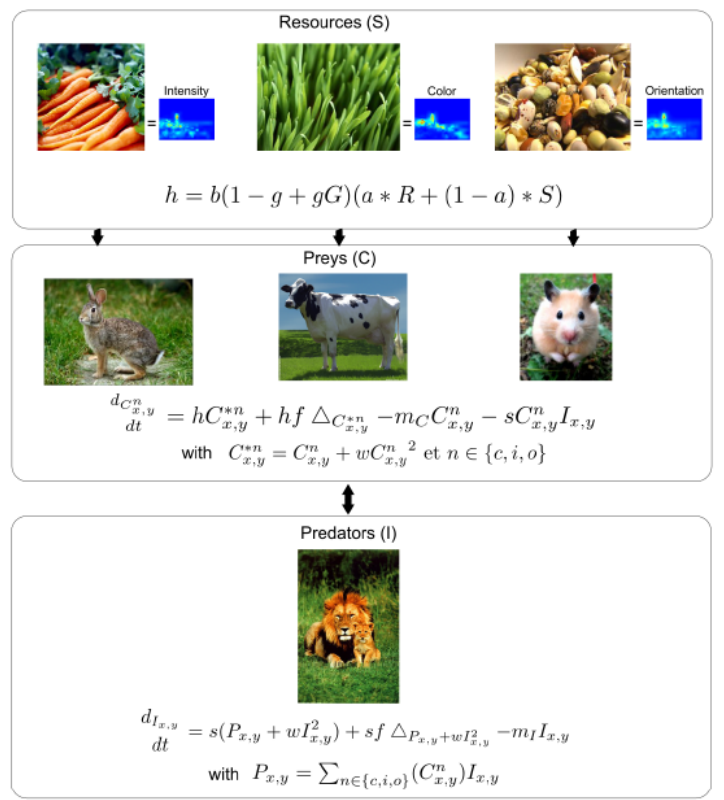
Figure 7. Competitive preys / predators attention model. Singularity maps are the resources that feed a set of preys which are themselves eat by predators. The maximum of the predators map represents the location of the current focus of